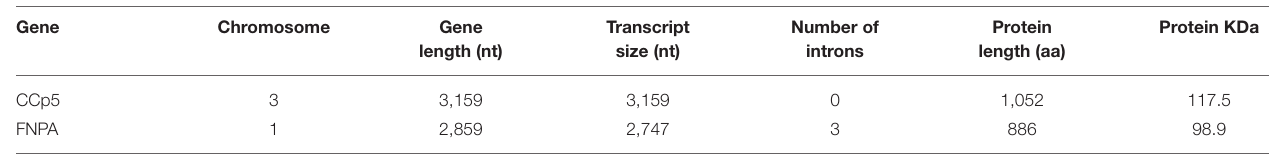
Transcript size (nt)